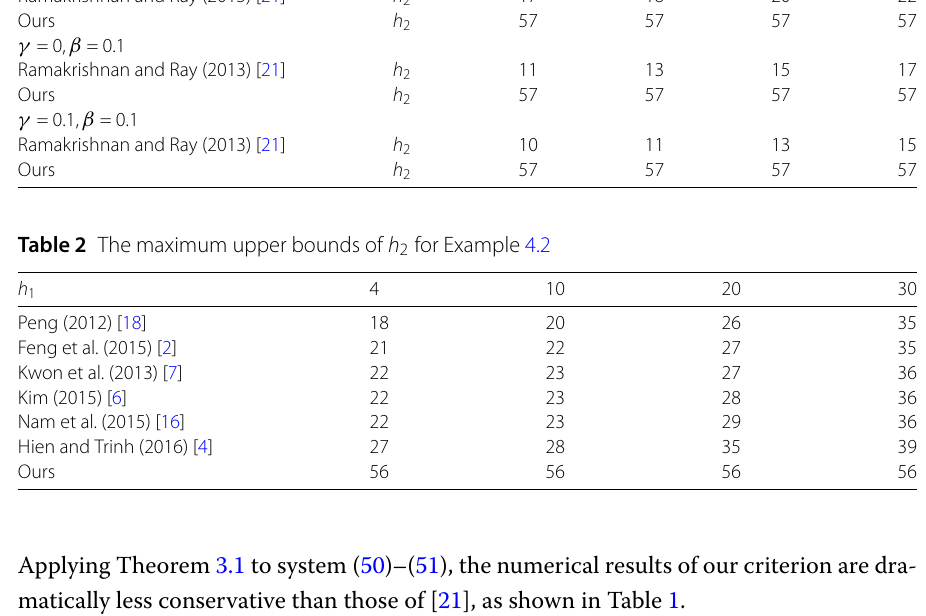
Table 1 The maximum upper bounds of h 2 for Example 4.1 Method h 1 2 γ = 0, β = 0